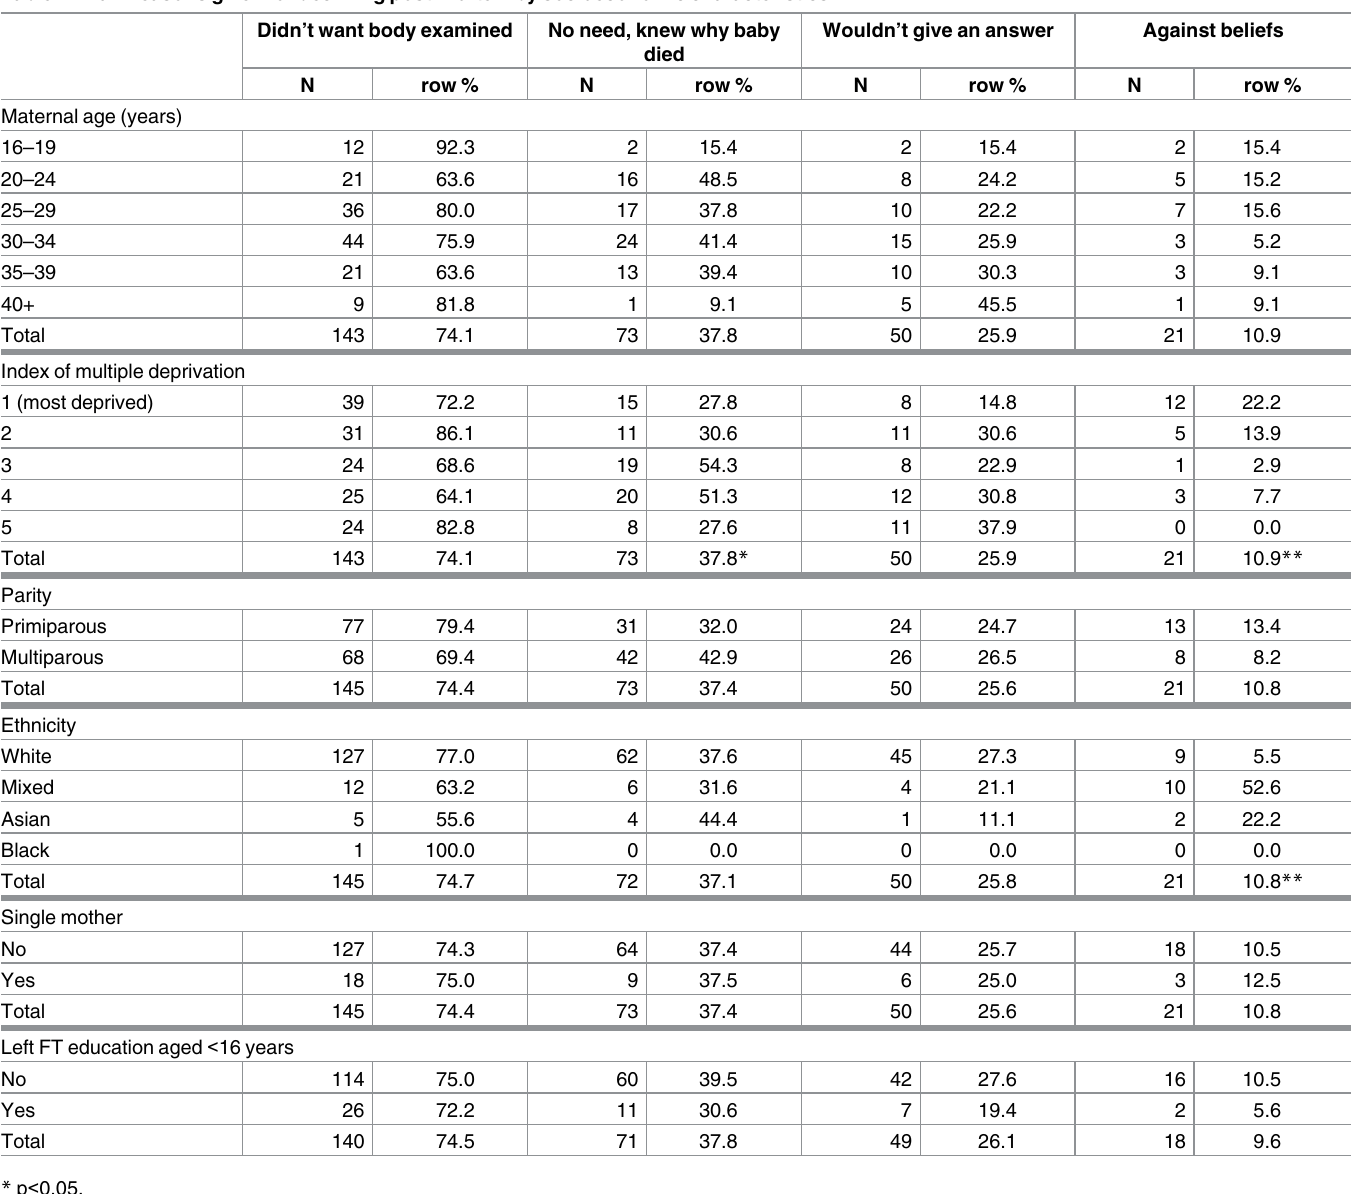
Table 4. Main reasons given for declining post-mortem by socioeconomic